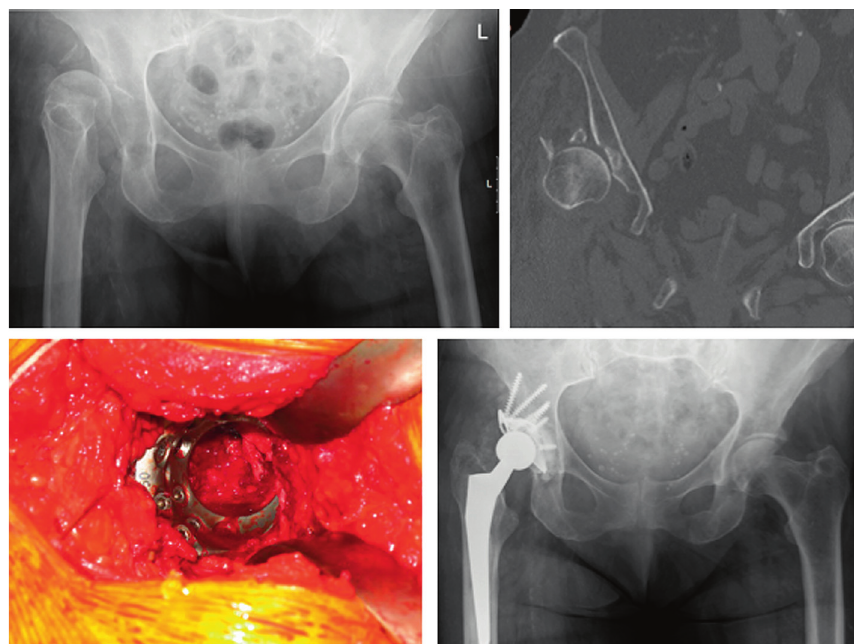
Figure 3. Due to a low energy fall a 84-year-old female patient presented with a Pipkin-IV fracture. The femoral head and the acetabular rim were fractured, the patient presented with a dislocation of the hip. Due to atrial fibrillation permanent anticoagulation with warfarin was present. Following bridging, the individualized treatment included acute total hip replacement (THR) with a Müller acetabular reinforcement